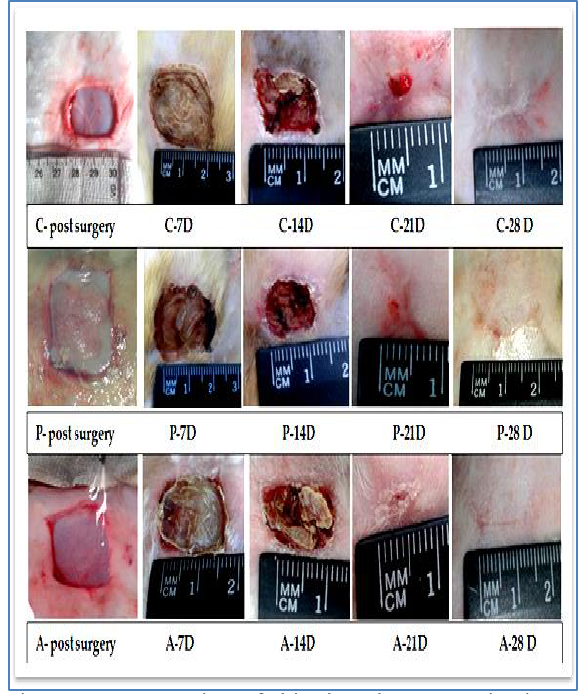
Figure, 1: Gross sections of skin showed macroscopic picture macroscopic picture of the of three groups at the different periods, C (control), P(pericardium), A(Amniotic, D(day).